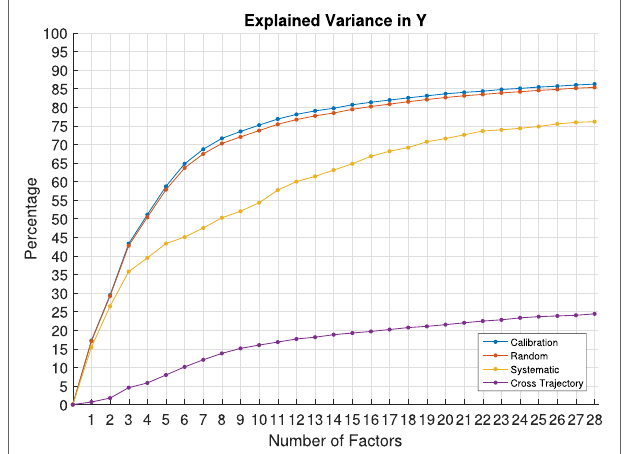
FIGURE 10 | Modified PLSR results. Comparison of various cross-validation